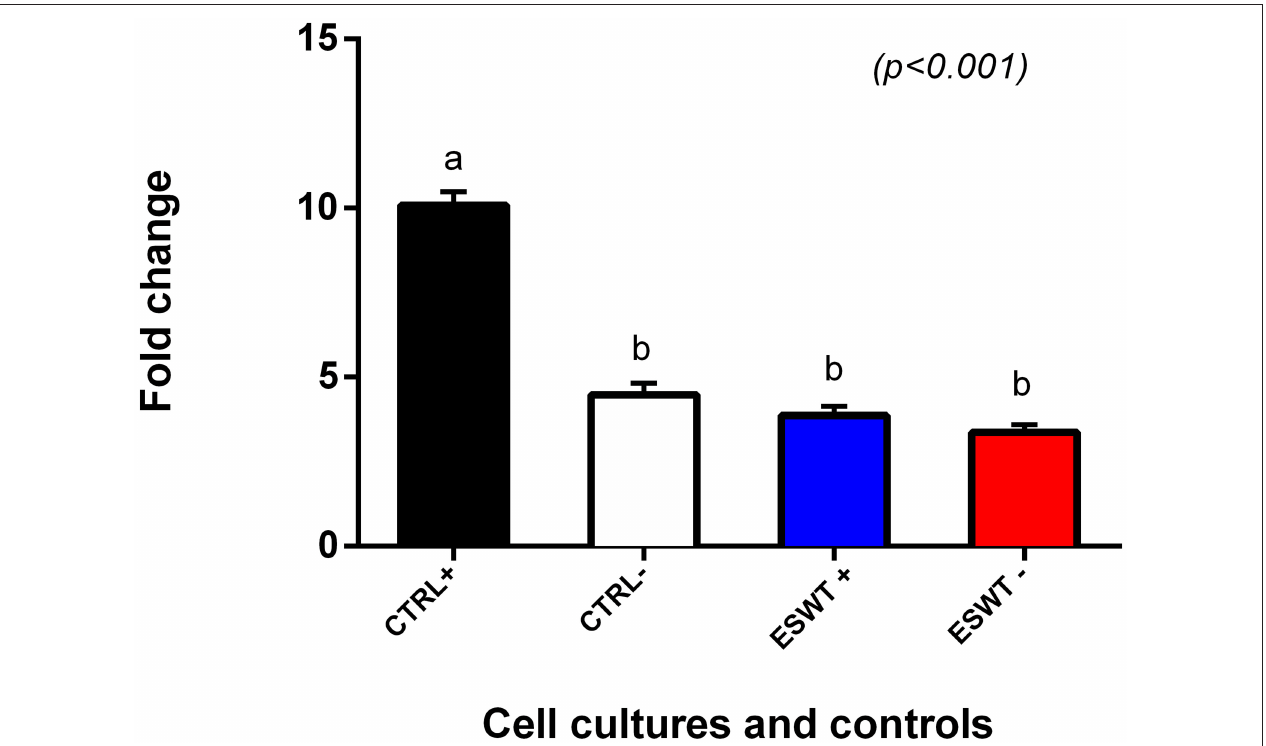
FIGURE 7 | Mononuclear cell suppression assay. MNC suppression assay to determine MNC proliferation suppression capacity of equine CB-MSC. Both treated (ESWT + ) and untreated (ESWT–) equine CB-MSC were able to suppress the proliferation of stimulated lymphocytes to the level of unstimulated lymphocytes (CTRL–). Values with different letters are statistically